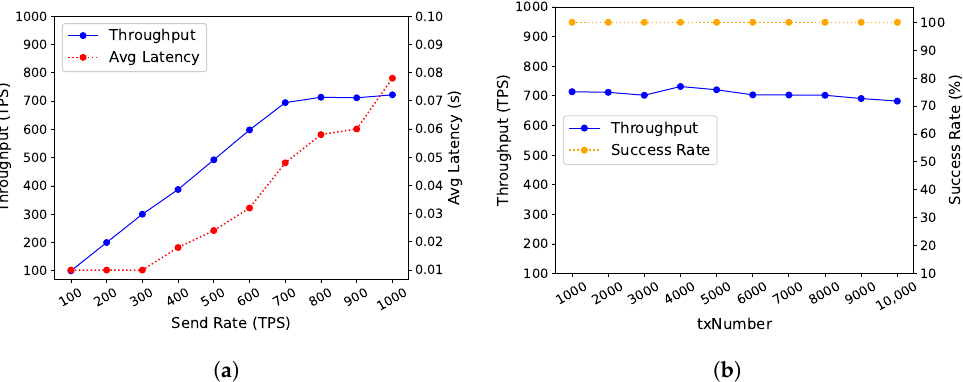
Figure 7. Performance of READ from HLF’s ledgers. ( a ) Performance of Different Send Rates with a TxNumber Equal to 2000. ( b ) Performance of Different TxNumber with a Send Rate Equal to